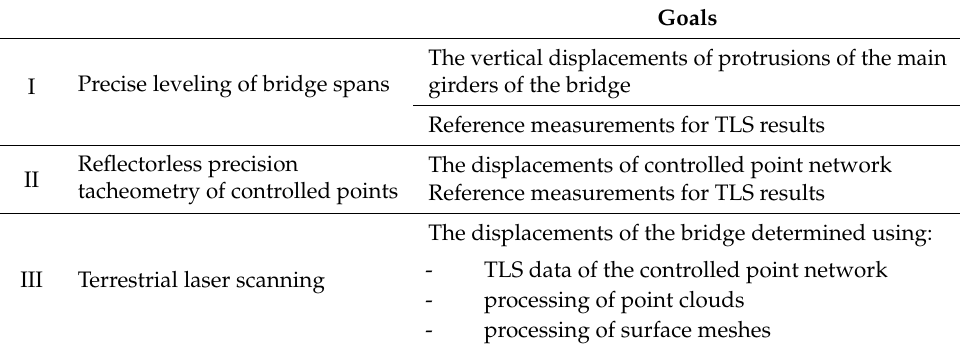
Table 2. Variants of the object displacement measurements. TLS: terrestrial laser scanner.